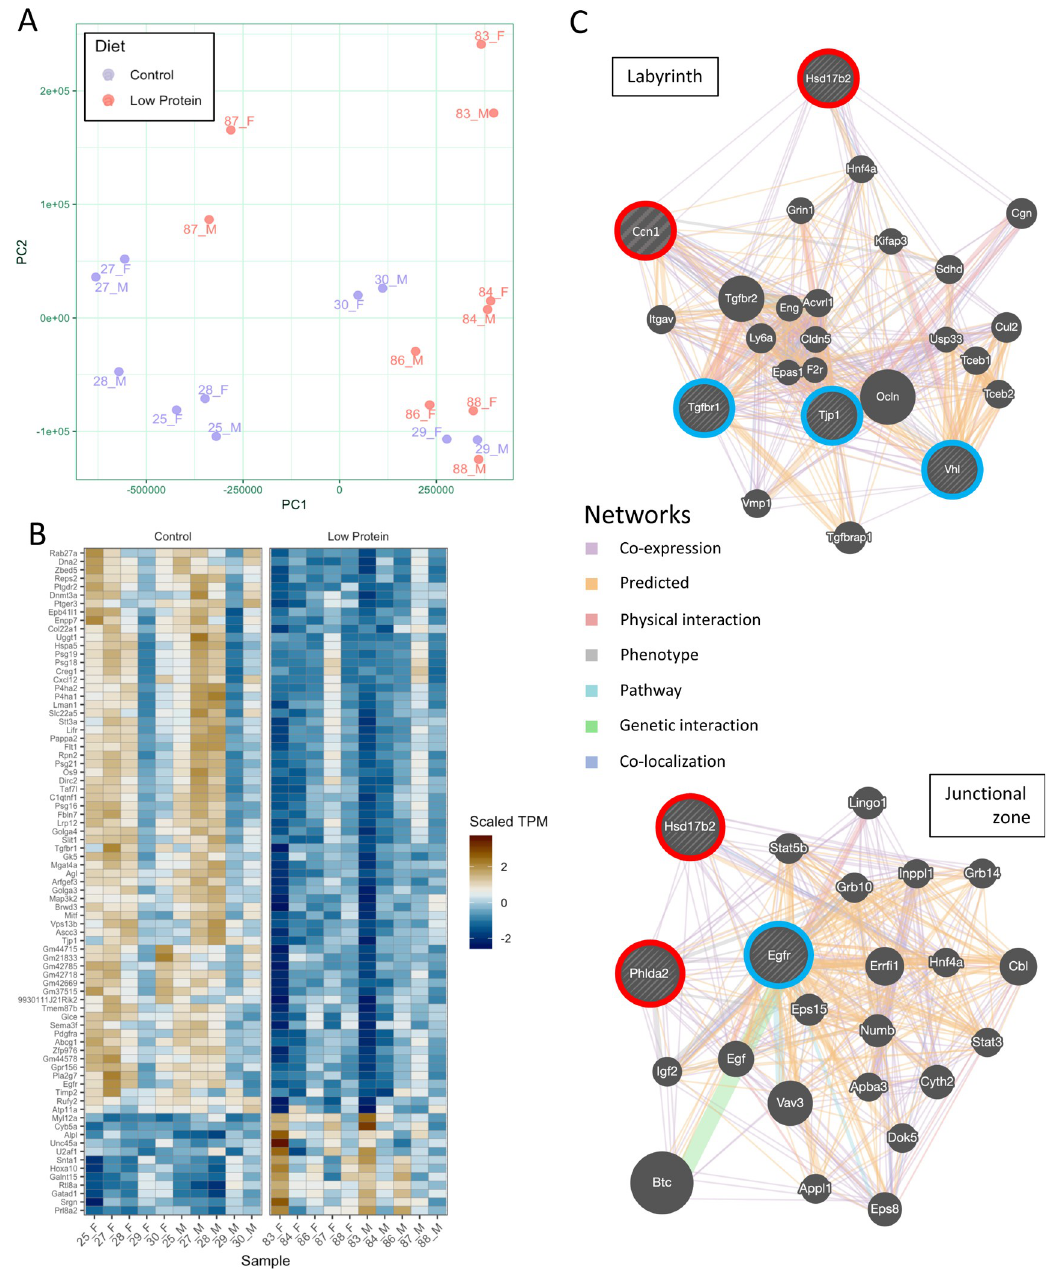
Fig 5. RNA sequencing analysis of Con and LP placentas at E16.5. (A) Principal component analysis with different points representing different litter (number) and sex within litter (male versus female). (B) Heat map of differentially expressed genes. (C) Gene network diagrams produced by GeneMania program, showing relationships between genes that are up- (red) or down- regulated (blue) in LP placentas (n = 5).